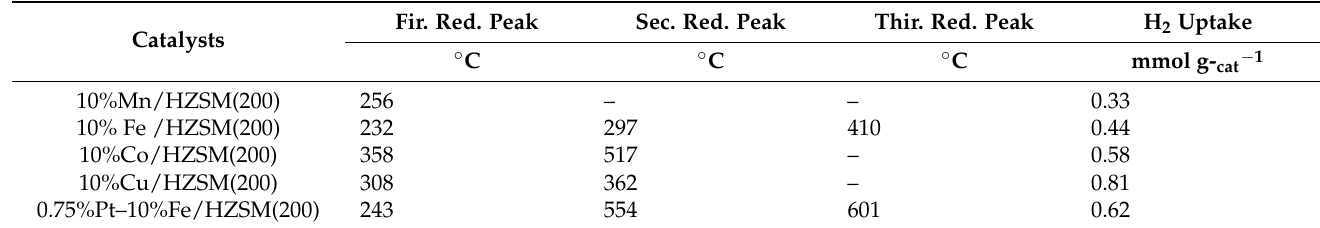
Table 5. H 2 uptake from the H 2 − TPR profiles of the different